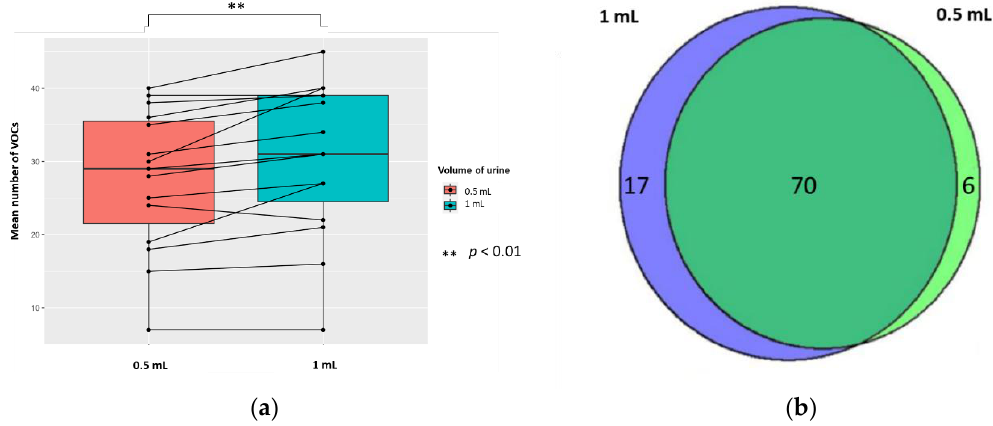
Figure 5. The urinary VOC profiles using 0.5 mL (red) and 1 mL of urine (blue) ( n = 15) treated with 5 M H 2 SO 4 , to yield 0.83 M final solution, pH 0.075. ( a ) Paired boxplot to show the cumulative number of unique VOCs produced per sample for either volume of urine. ( b ) Venn diagram showing the unique VOCs detected in each volume of urine.